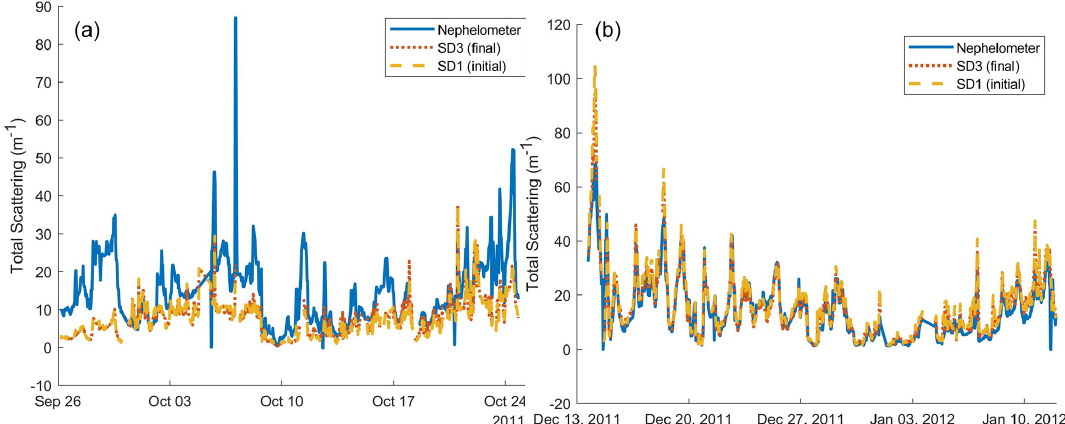
Figure A4. Examples of excluded (a) and included (b) nephelometer data (blue traces) compared to total scattering coefficients calculated from the indicated estimated size distributions (SD1 or